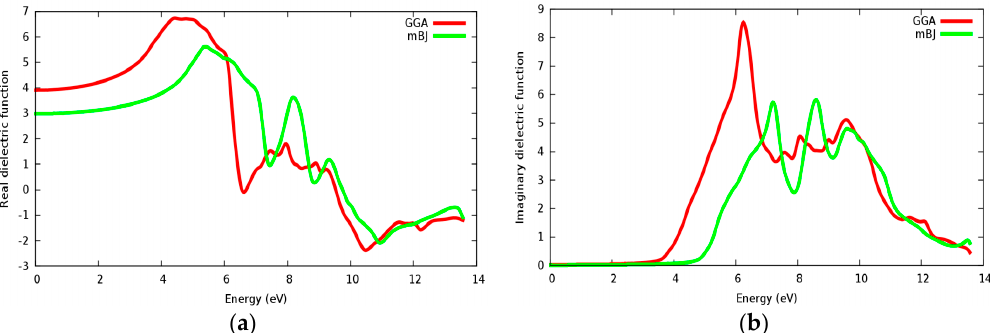
Figure 14. Dielectric function for SrZrO 3 : ( a ) Real part; ( b ) Imaginary part using both PBE-GGA and mBJ-GGA methods.